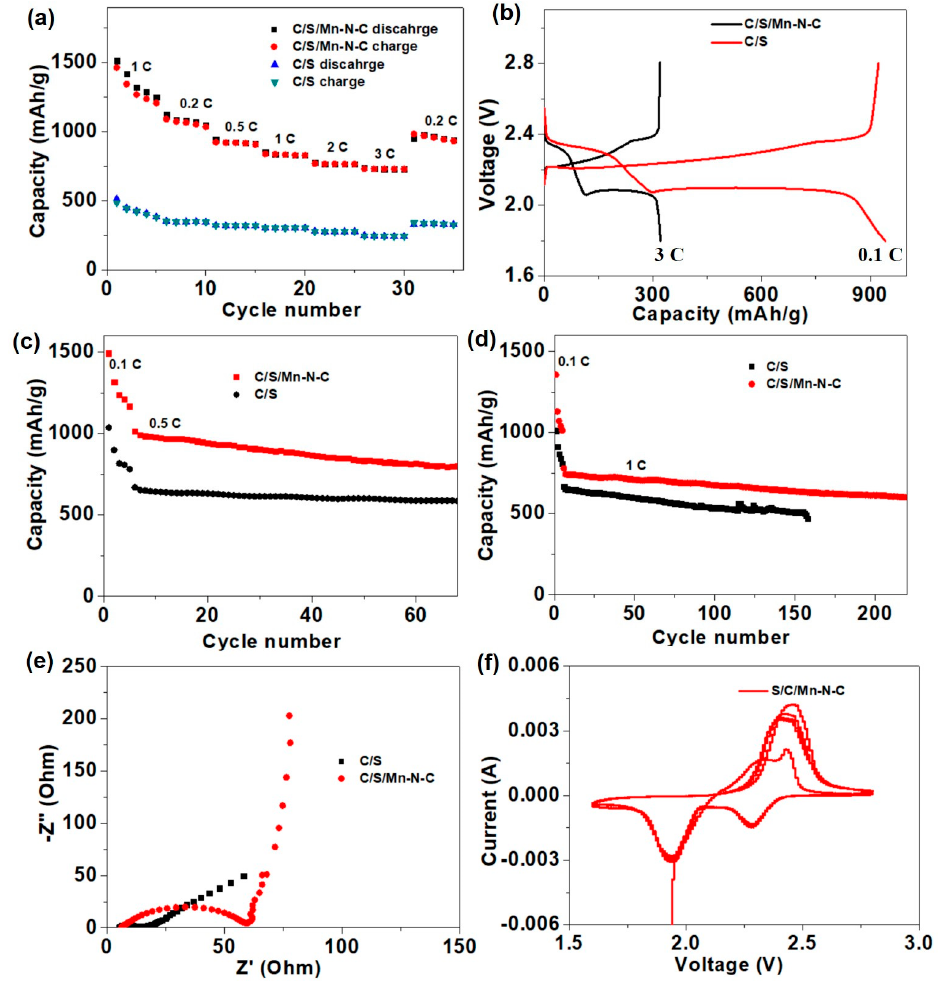
Figure 7. ( a ) Rate capacity comparison between Li-S batteries using C/S and C/S/Mn-N-C as the electrodes. ( b ) Galvanostatic charge-discharge voltage profiles of the C/S/Mn-N-C electrode at current densities from 0.1 to 3 C. Cycling performances at ( c ) 0.5 C and ( d ) 1 C for Li-S batteries assembled with C/S and C/S/Mn-N-C electrodes. ( e ) Nyquist plots of Li-S batteries assembled with C/S and C/S/Mn-N-C electrodes. ( f ). CV curves of the Li-S battery using C/S/Mn-N-C as the electrode.